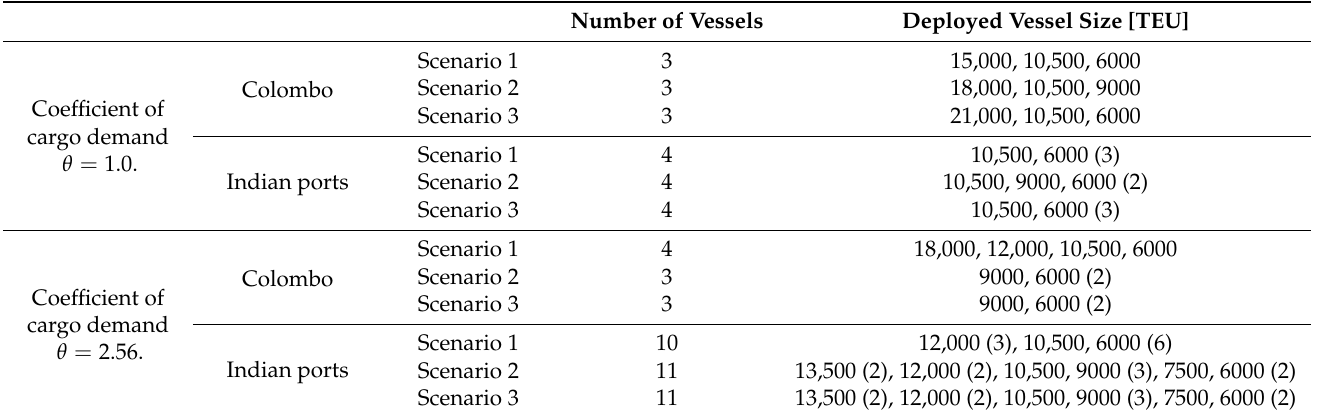
Table 5. Results of size of deployed vessels for Colombo and Indian